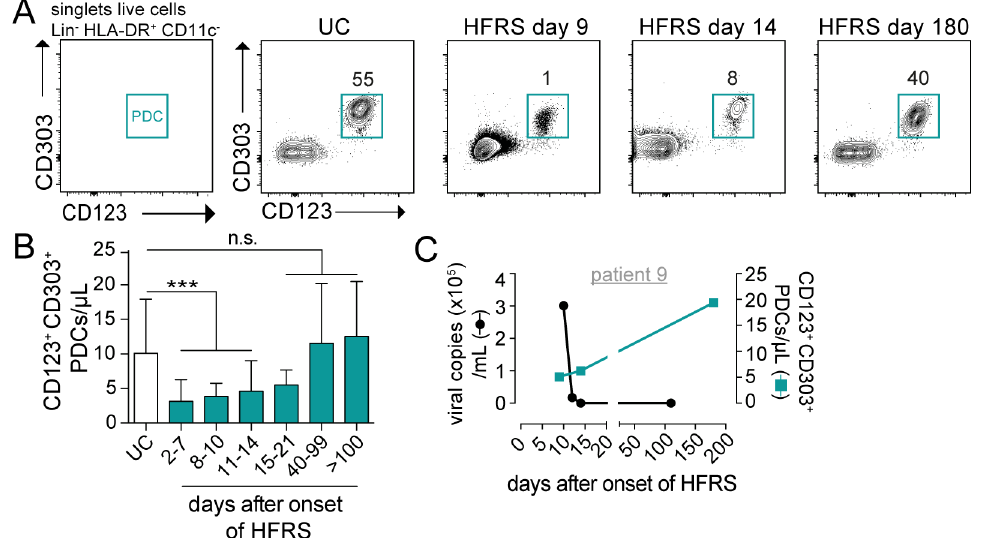
Fig 5. Decreasednumber of PDCs in blood during acute HFRS. ( A ) Gating strategy for the identification of PDCs (teal) by flow cytometry after gatingout lineage(CD3, CD20, CD56) cells, and gatingon HLA-DR + CD11c - cells. Representative flow cytometry plots from one representative UC and HFRS patient are shown. ( B ) Mean ± SD absolutenumbersof PDCs were evaluatedin longitudinal samplesin HFRS patients in comparisonto UC. ( C ) Graphs show detectableviral load in plasma measuredby viral RNA quantification from one representative HFRS patient Virologicaldata (left axis; black line) and absolute numbers of PDCs (right axis; colored line) are shown over time from one representativeHFRS patient. Differences in mean absolutenumber of PDCs were assessedusing Poissonregression: *** p < 0.001,n.s. not significant.